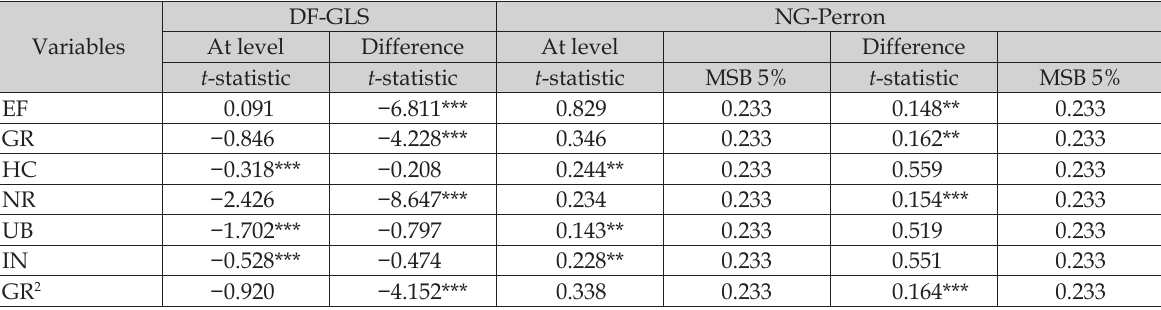
Fig. 1. Plots of the series. EF – ecological footprint; HC – human capital; NR – natural resources; UB – urbanisation. Source: own compilation. Table 4. Results of the DF-GLS and NG-Perron unit root